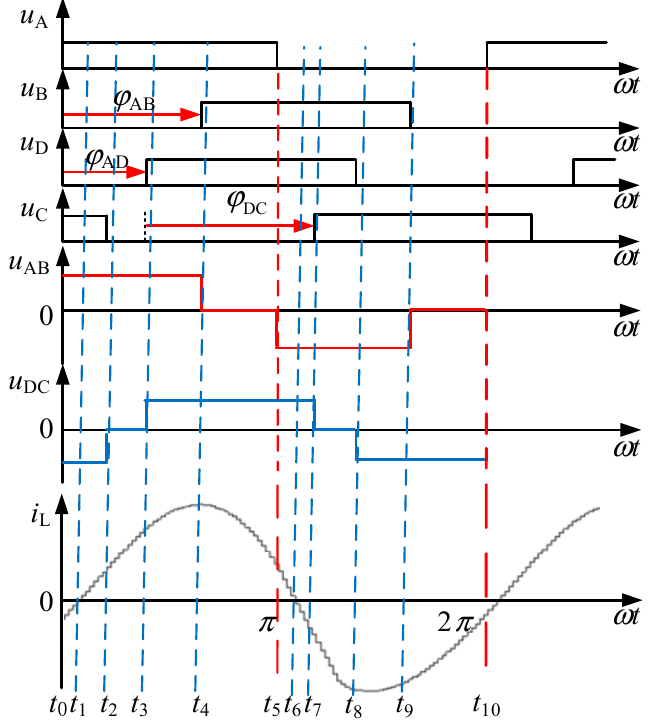
Figure 5. Work waveform under TPS modulation.